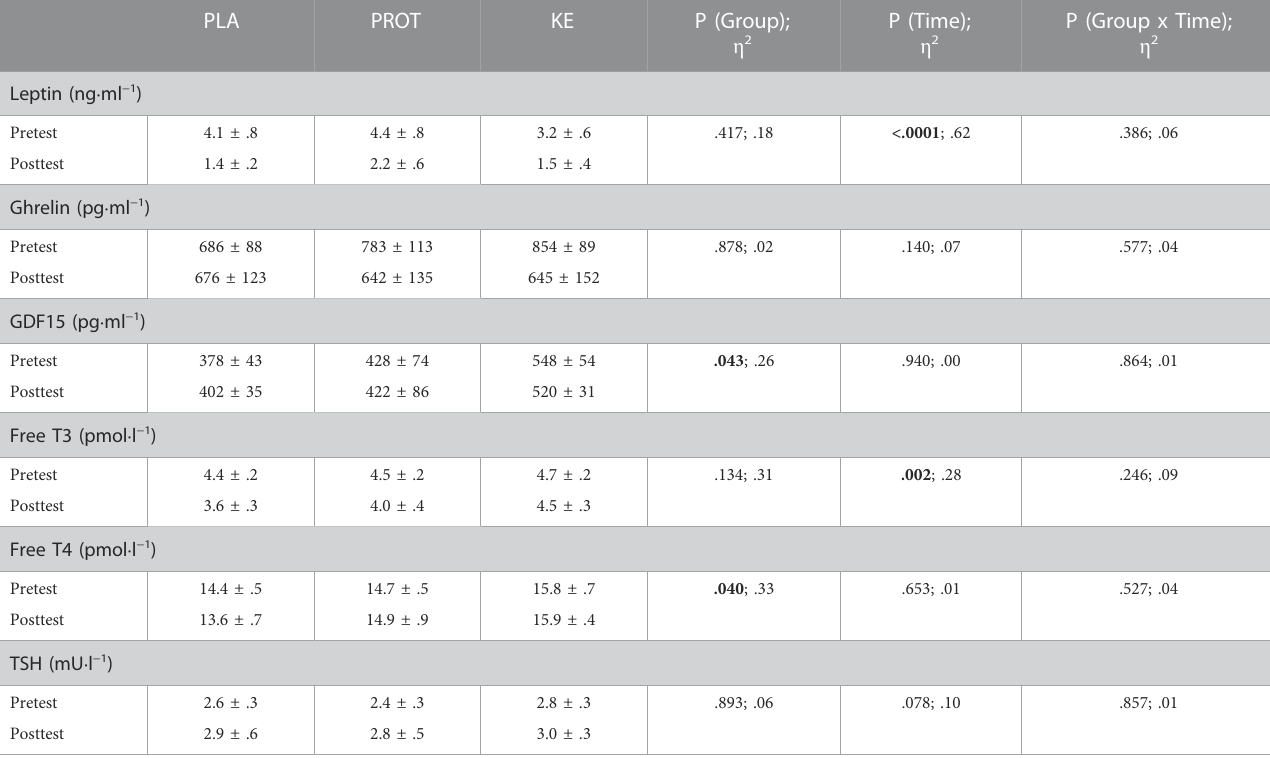
TABLE5Effectofincreasedproteinintakeandexogenousketosisonhormonalparametersduringahypocaloricdiet.Dataaremean±SEM.Subjectswereinvolvedina 4-week hypocaloric diet (30% energy restriction, .8 – 1.0 g protein · kg BW − 1 · day − 1 ) and received either placebo (PLA: n = 11), an increased amount of dietary protein (PROT: n = 9) or a ketone ester (KE: n = 11). Hormonal parameters were measured before (pretest) and at the end (posttest) of the caloric restriction period. Signi fi cant main effects are shown in bold and effect sizes are reported as eta squared ( η 2